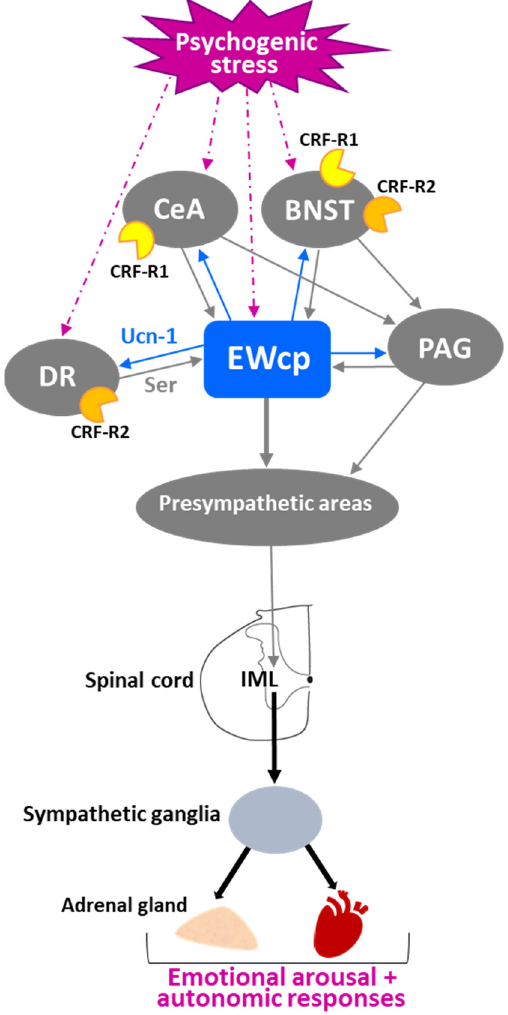
Figure 7. Connections of EWcp with the circuit activated by psychogenic stressors, which evokes emotional arousal and autonomic responses. One of the branches of this circuit comprises the activation of limbic regions (CeA and BNST) that project to PAG that, in turn, projects to brainstem presympathetic neurons that control sympathetic outflow. As with PAG, EWcp receives afferent projections from limbic regions and projects to brainstem presympathetic neurons. This parallelism suggests that EWcp could be a key element of an additional pathway that conveys limbic information to the autonomic brainstem, besides the classic pathway via PAG. EWcp has reciprocal connections with CeA, BNST, PAG, and with serotonergic neurons (Ser) in dorsal raphe (DR), which are activated by psychogenic stressors and express high density of CRF-R2. For terms, see the list of abbreviations.